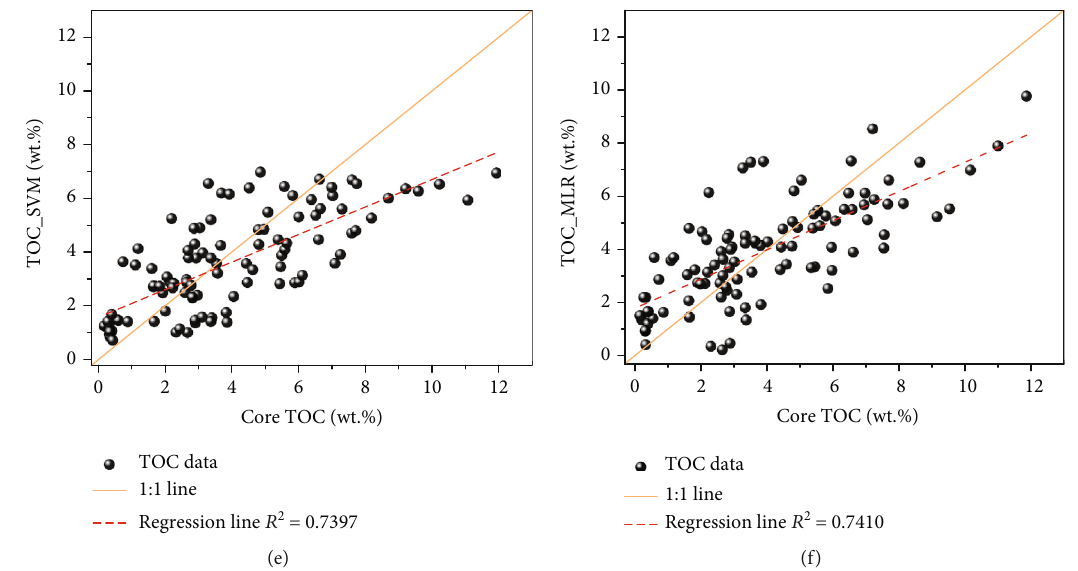
Figure 7: Crossplots of the predicted TOC and core-measured TOC content: (a) XGBoost model, (b) RF model, (c) △ log R method, (d) KNN model, (e) SVM model, and (f) MLR model.